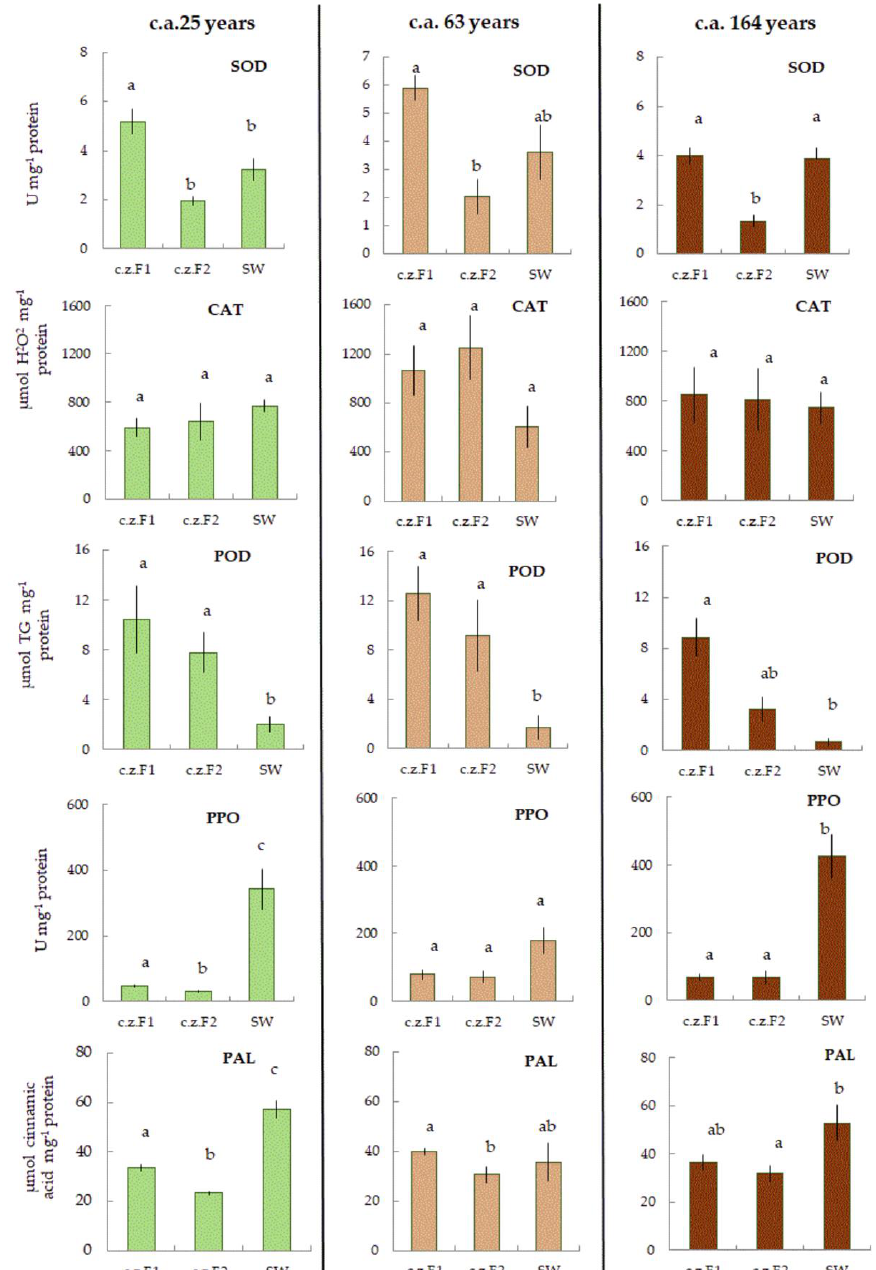
Figure 2. The activities of superoxide dismutase (SOD) (U mg − 1 protein), catalase (CAT) (µmol H 2 O 2 mg − 1 protein), peroxidase (POD) (µmol TG mg − 1 protein), polyphenol oxidase (PPO) (U mg − 1 protein), and phenylalanine ammonia-lyase (PAL) ( μmol cinnamic acid mg − 1 protein) in Fraction 1 (cambial zone, conducting phloem, non-conducting phloem) (F1), Fraction 2 (differentiating xylem) (F2), and sapwood (SW) of 25, 63, and 164 cambial age (c.a.) years Scots pine trees. Values represent the mean ± SE ( n = 5). The difference was considered significant if p < 0.05. Letters indicate differences between groups F1, F2, and SW.